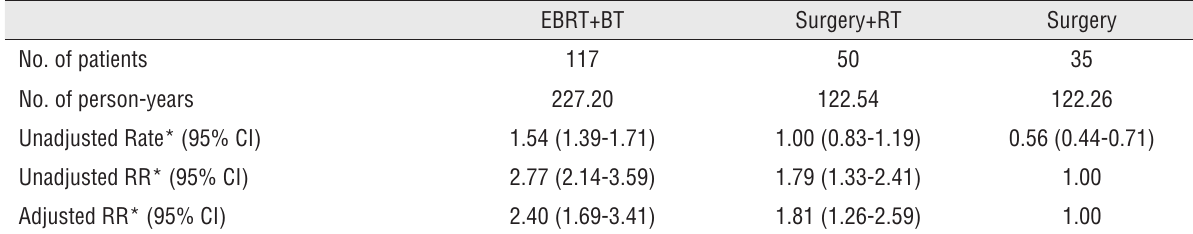
Hispanic, Asian, other/unknown), FIGO stage (1, 2, 3, 4, unknown), and Charlson comorbidity score (0, 1, 2+)